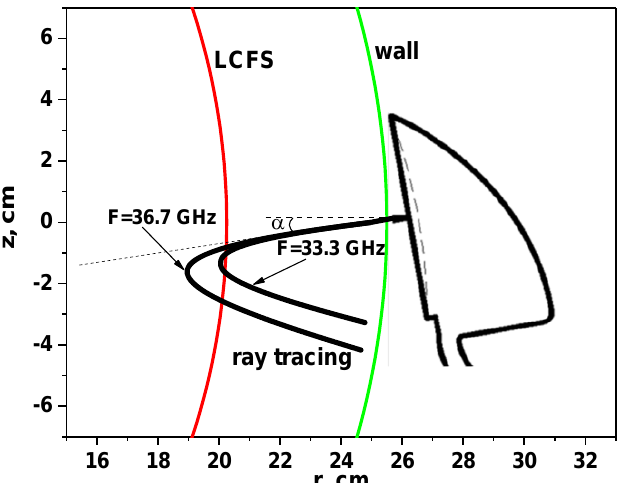
Figure 5. Ray tracing of the probing beams of the DBS diagnostic in the TUMAN-3M tokamak.